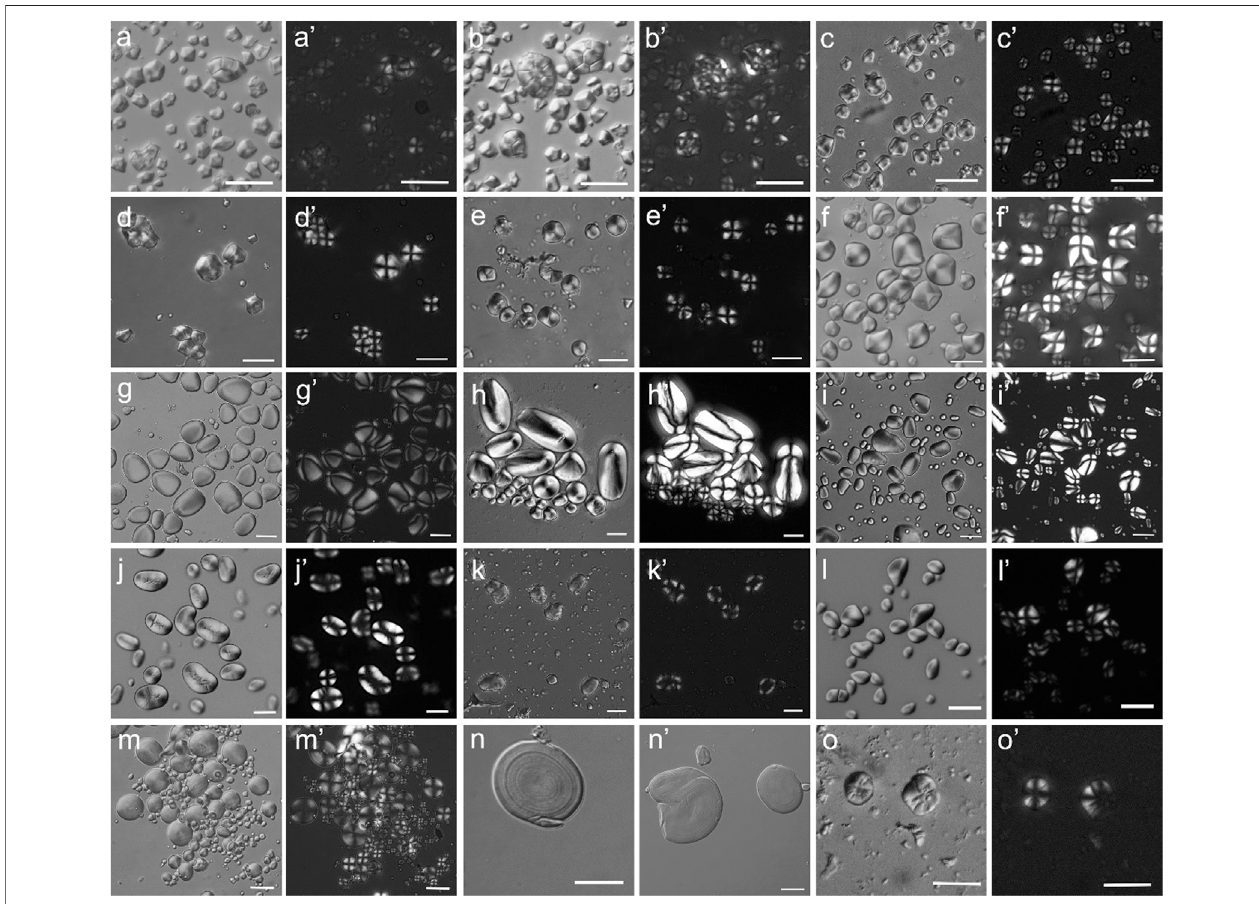
FIGURE 3 | Relevant reference collection of modern starch grains at the University of Science and Technology of China — (a,a ’ ) rice from Hunan, China; (b,b ’ ) rice from Fujian, China; (c,c ’ ) broomcorn millet from Shaanxi, China; (d,d ’ ) foxtail millet from Shaanxi, China; (e,e ’ ) Job ’ s tears from Anhui, China; (f,f ’ ) roots of snake gourd from Anhui, China; (g,g ’ ) Chinese yam from Henan, China; (h,h ’ ) lotus root from Henan, China; (i,i ’ ) lily bulbs from Gansu, China; (j,j ’ ) mung bean from Henan, China; (k,k ’ ) sweet pea from Anhui, China; (l,l ’ ) acorns ( Quercus acutissima ) from Anhui, China; (m,m ’ ) wheat from Anhui, China; (n,n ’ ) wheat after boiling; and (o,o ’ ) Job ’ s tears after grinding (scale bar: 20 μ